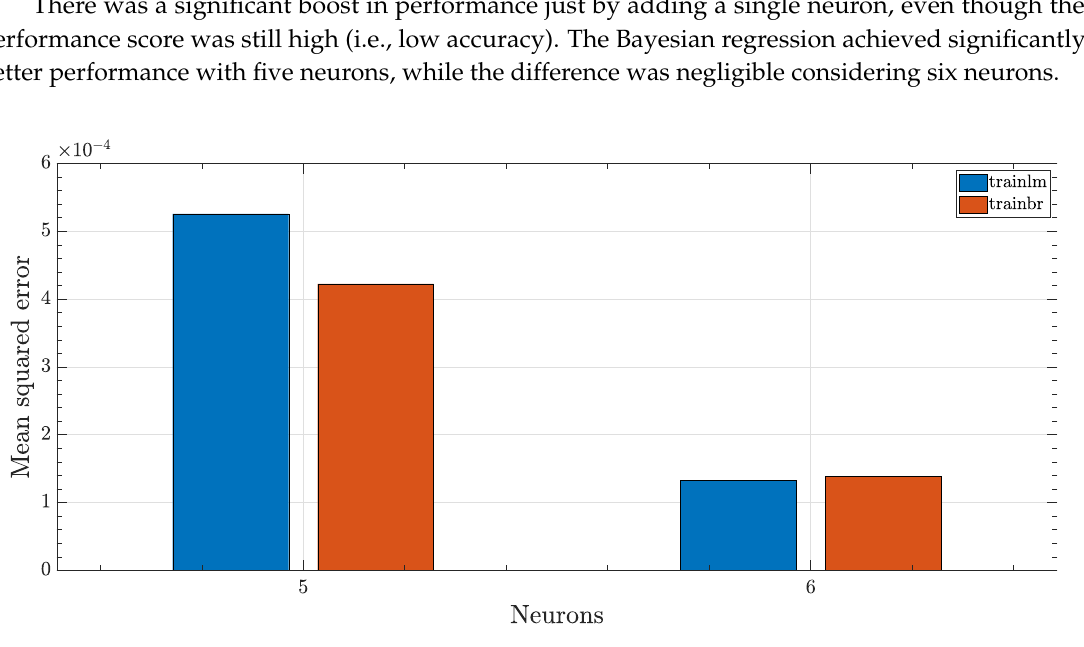
Figure 10. Single hidden layer networks performance as function of neurons and training function, sampling mode